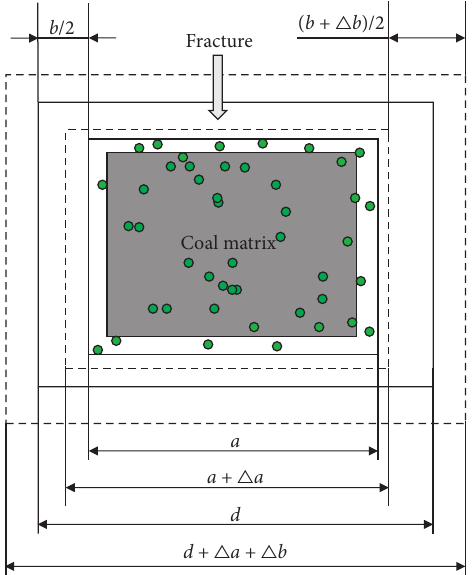
Figure 4: Representative element volume (REV) model for coal